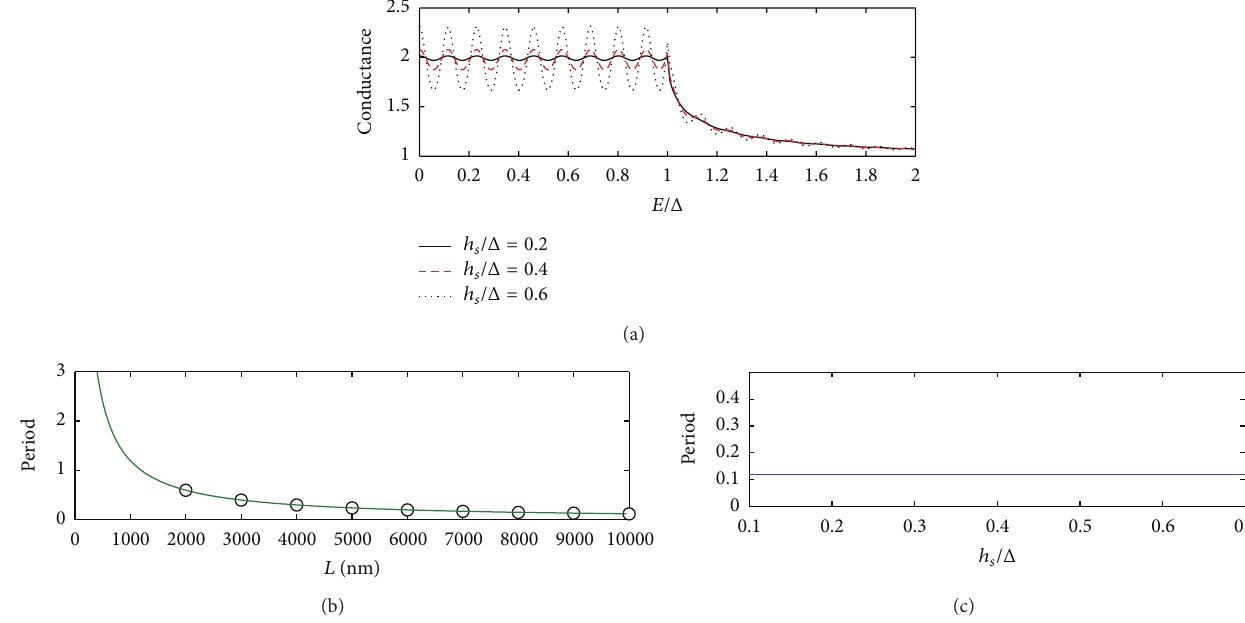
Figure 2: (a) Normalized tunneling conductance versus bias voltage for different exchange fields, (b) period of conductance oscillations versus thickness of intermediate layer, and (c) period of conductance oscillations versus exchange field of ferromagnetic superconductor.